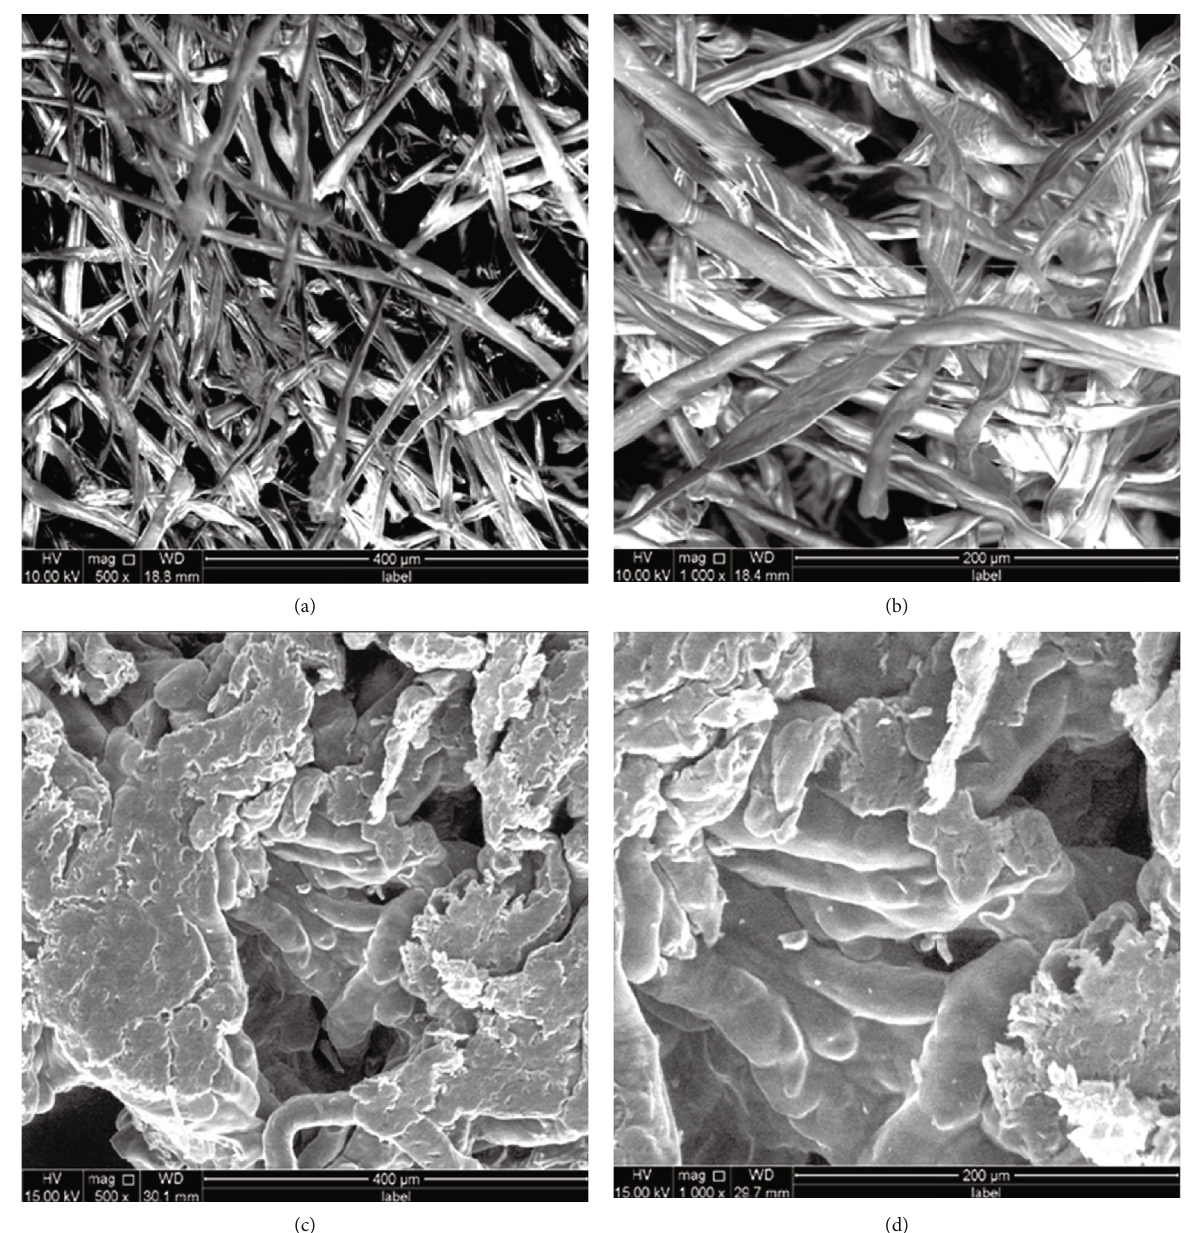
Figure 4: SEM micrograph of waste textile cotton (a, b) and CMC (DS — 0 : 998 ± 0 : 007 ; c,